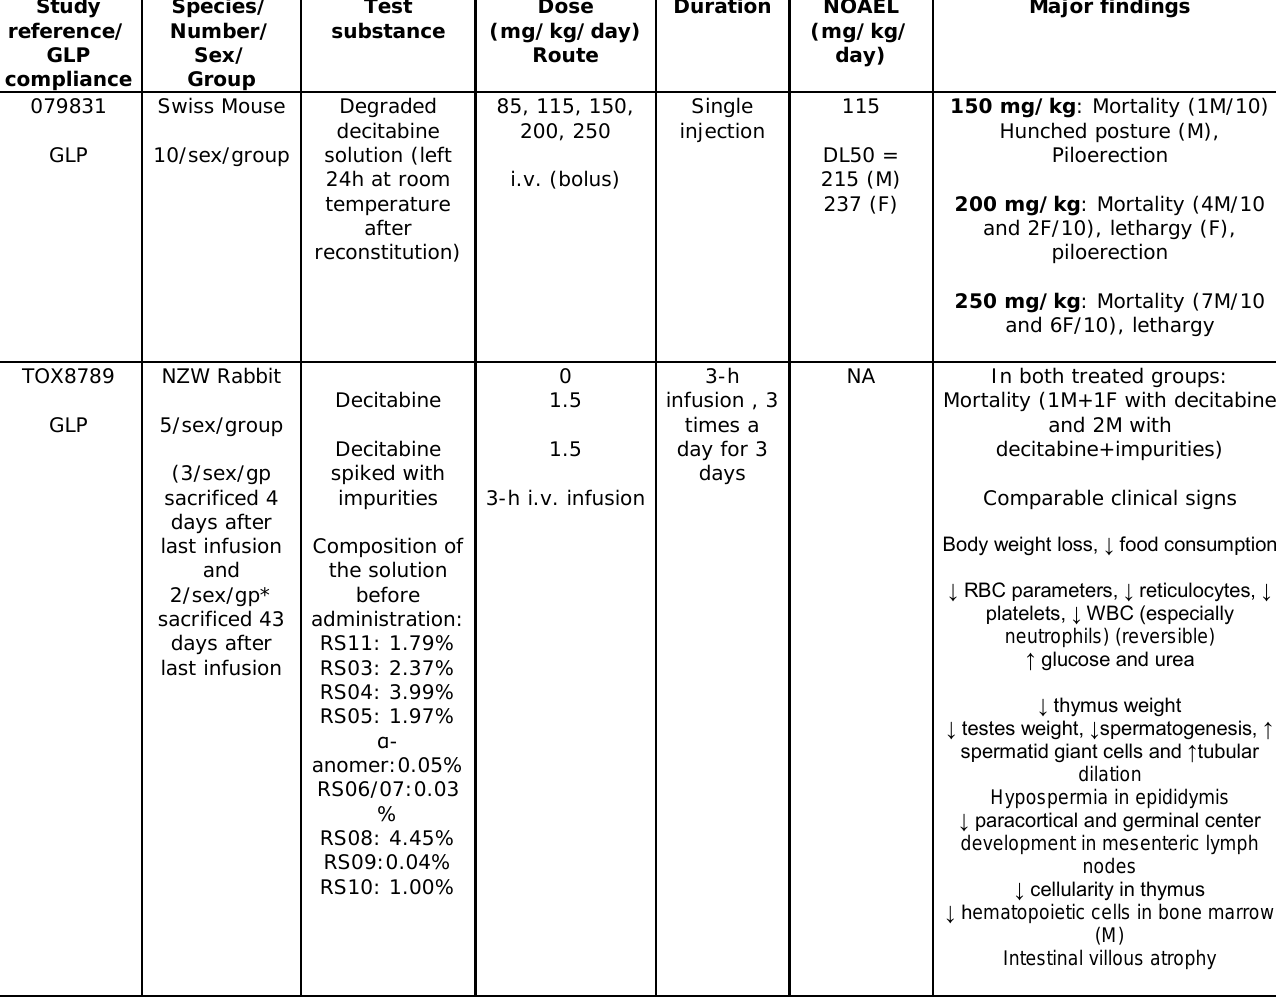
Table 12: Summary of studies on impurities Study reference/